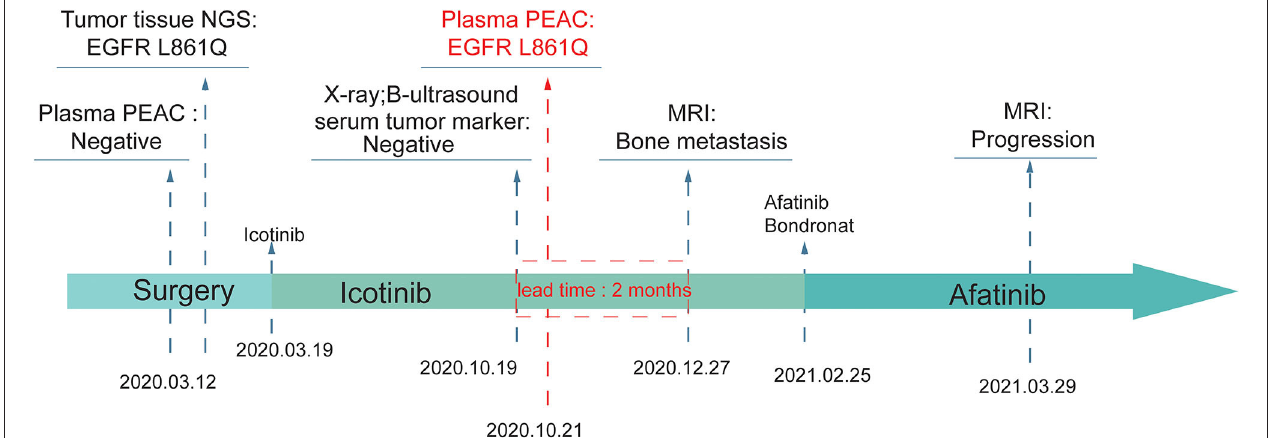
FIGURE 5 | An example of MRD detection for tumor relapse monitoring using PEAC system . An EGFR L861Q mutation was detected by PEAC using plasma sample 7 months after surgery, which was also identified by NGS in tumor tissue sample. The patient was found relapsed 2 months later by magnetic resonance (MR)